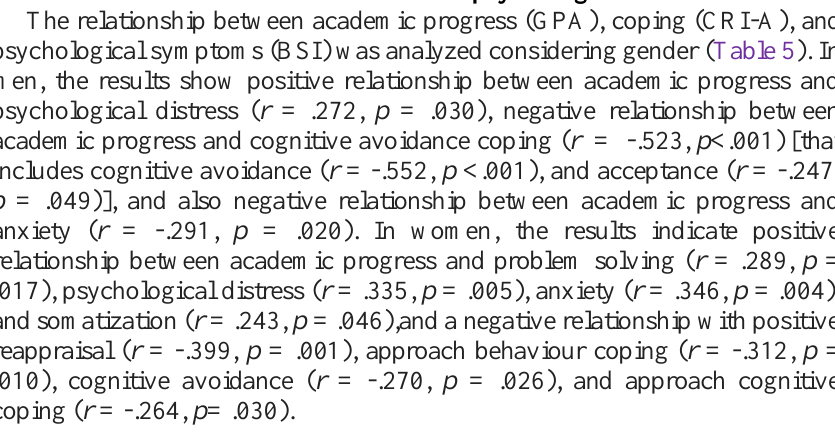
Correlations between academic progress (GPA), coping (CRI-A) and psychological distress (BSI) by gender Coping Strategies Approach cognitive coping .042 Logical